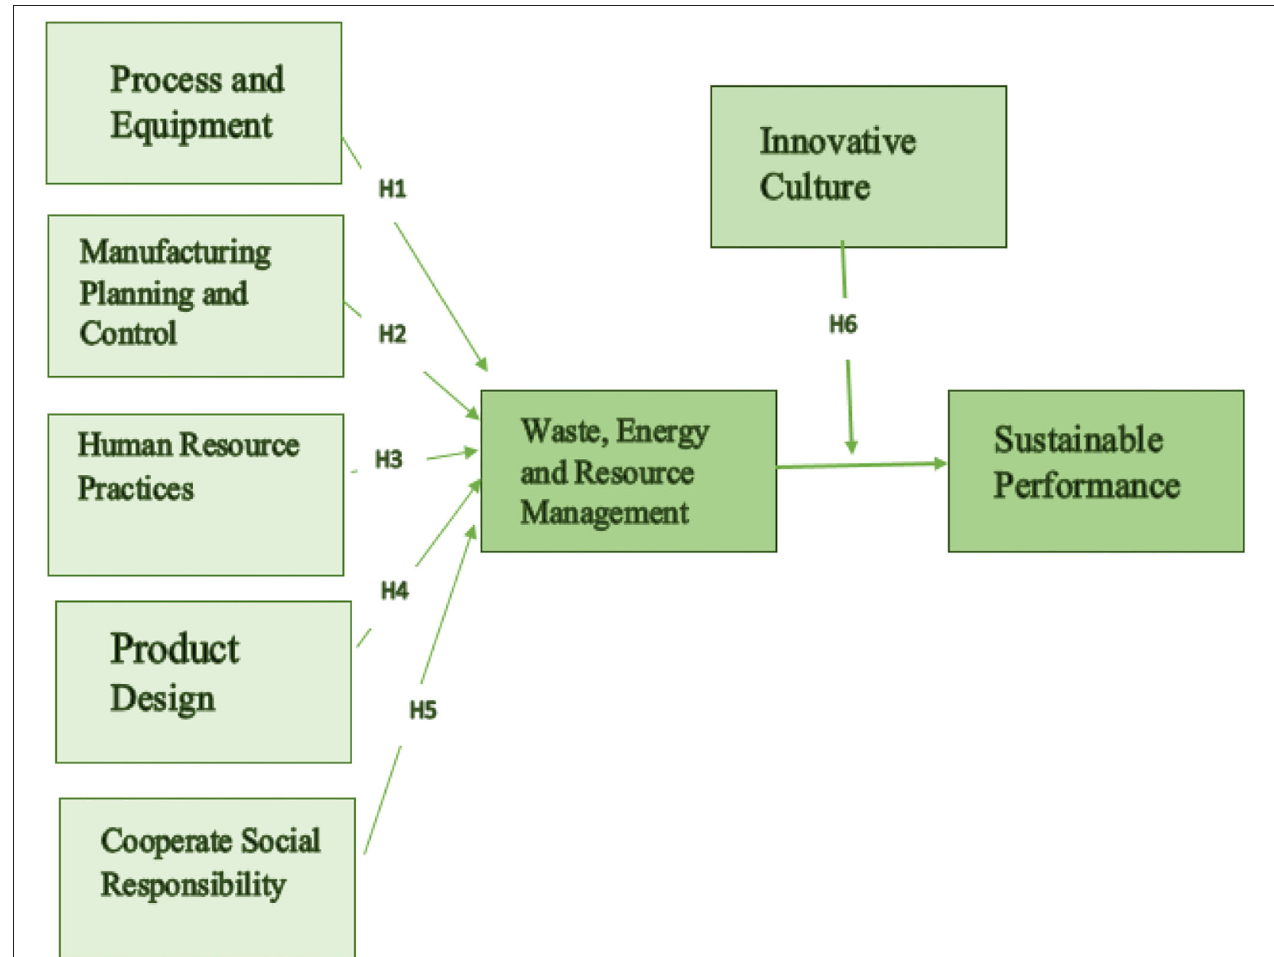
FIGURE 1 | Conceptual